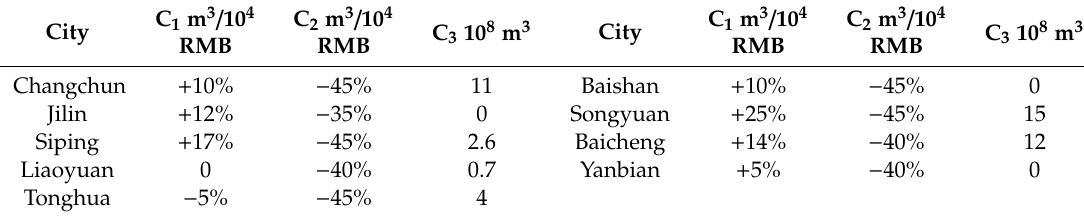
Table 7. Regulation program of WRCC.